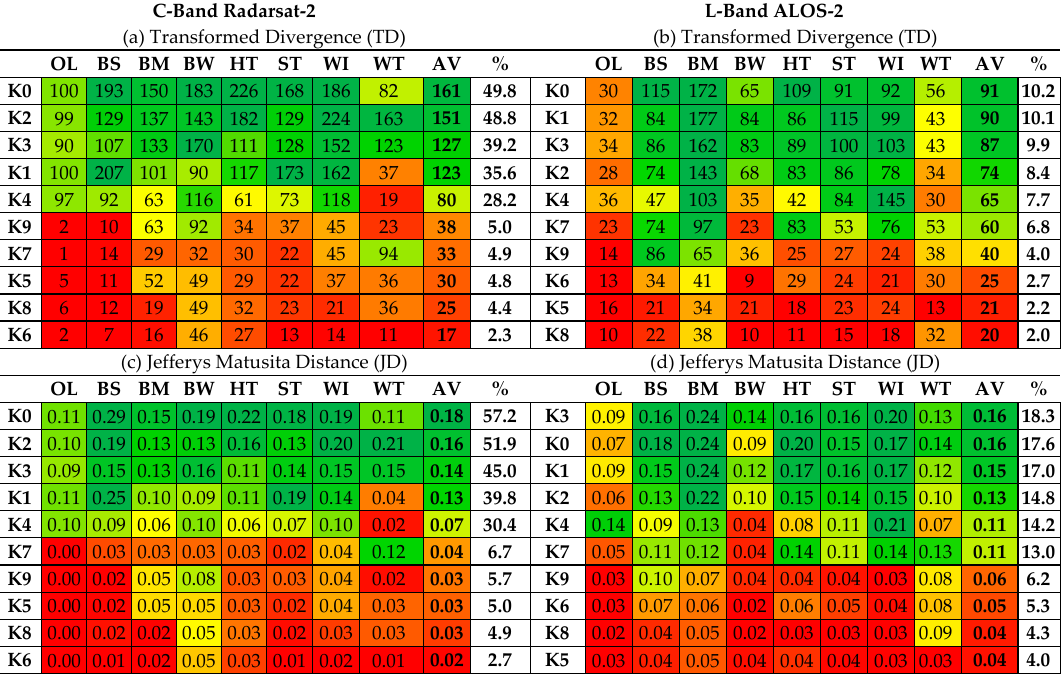
OL BS BM BW HT ST WI